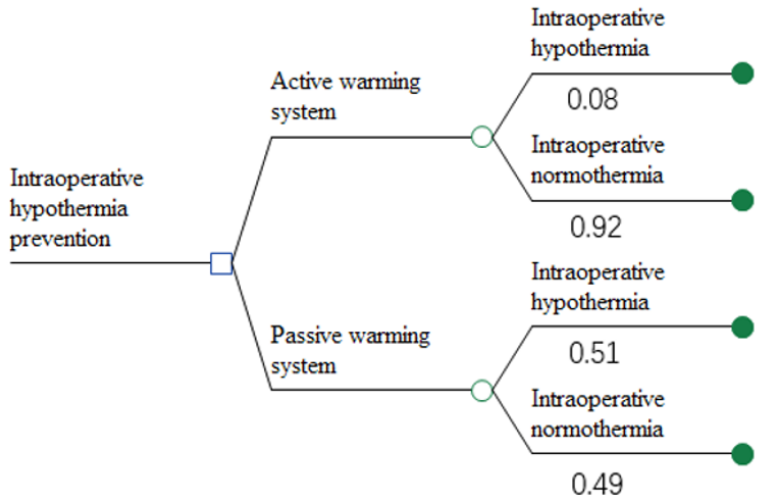
Figure 1. Decision tree for the effect of active versus passive warming on the occurrence of intraoper- ative hypothermia in major surgeries.